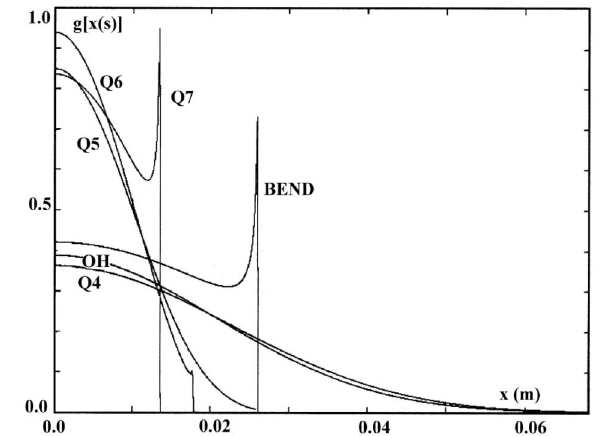
FIG. 2. Transverse horizontal beam density profiles g (cid:1) x (cid:2) [Eq. (1) or, as well, a subproduct of the numerical solution of Eq. (5)] at various optical elements along the beam line shown in Fig. 1, given a sole octupole component ( n (cid:1) 1 ) at